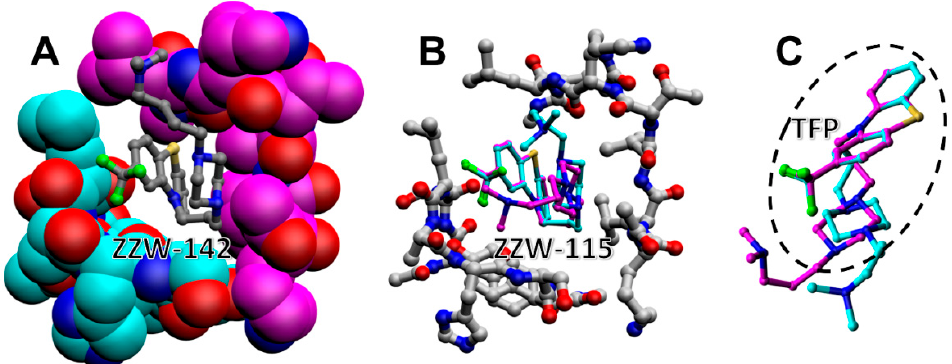
Figure 2. Docking of compounds into the simulated binding pocket of NUPR1: ( A ) Compound ZZW-142 bound into an example of transient pocket formed by the 7-residue regions of NUPR1 centered around Ala33 (cyan) and Thr68 (magenta). ( B ) Cross-docking of compound ZZW-115 into the same binding pocket, showing two different conformations (cyan and magenta). ( C ) Details of the two conformations of ZZW-115 from a different orientation, highlighting the TFP scaffold and the differences in the alkylated tail conformation.